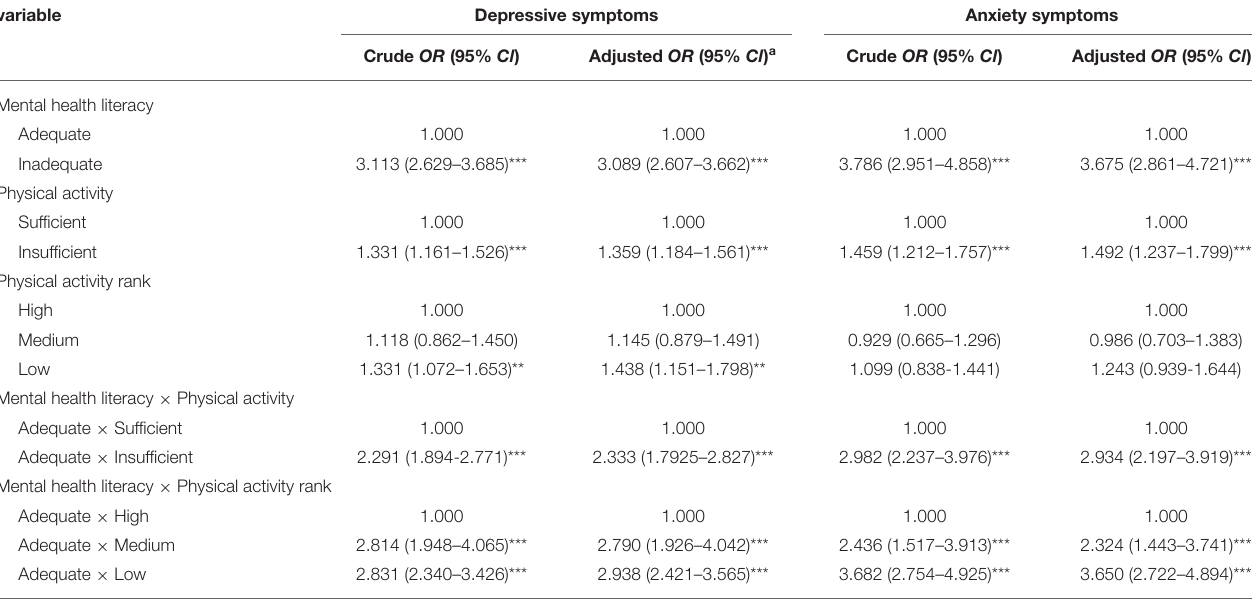
TABLE 2 | Association of physical activity, mental health literacy, depressive symptoms and anxiety symptoms in Chinese college students.